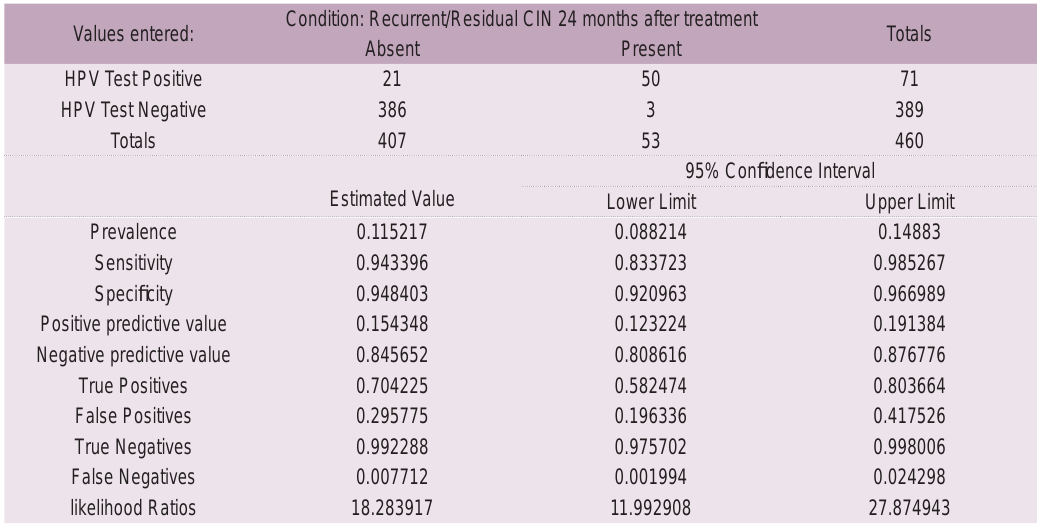
TABLE 3. The role of HPV testing in the follow-up of patients 24 months after treatment for